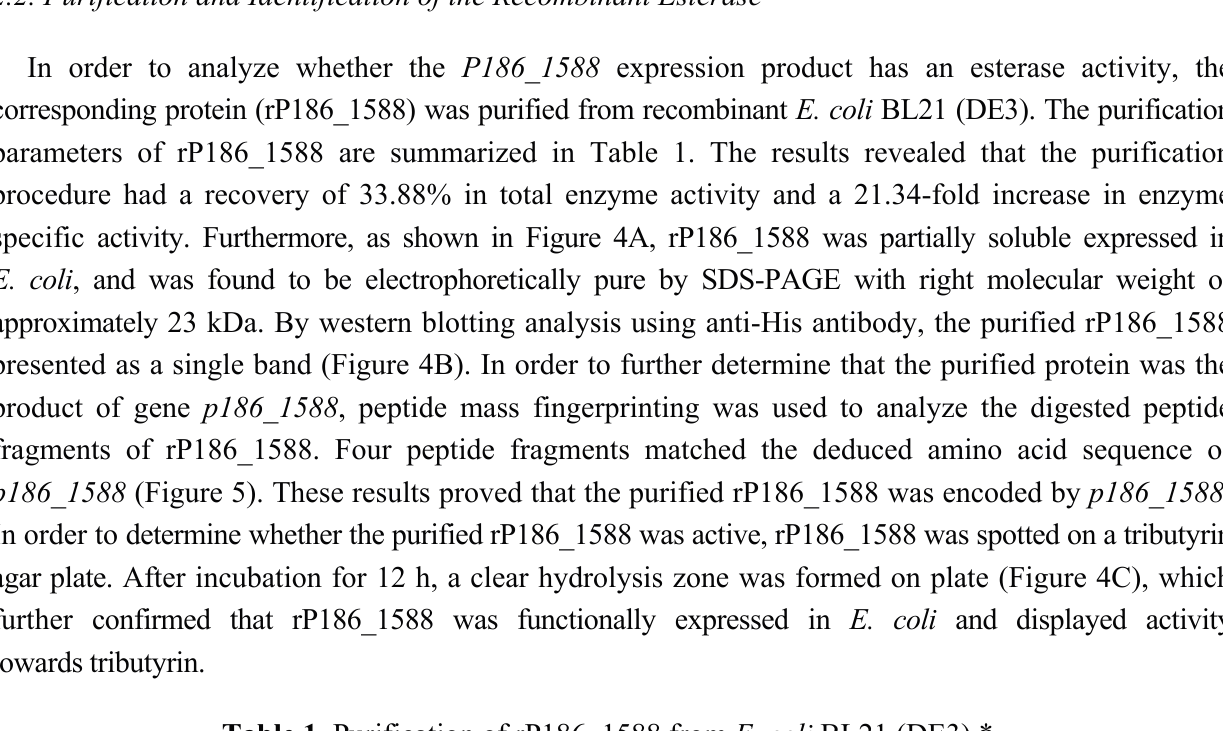
Table 1. Purification of rP186_1588 from E. coli BL21 (DE3) *.